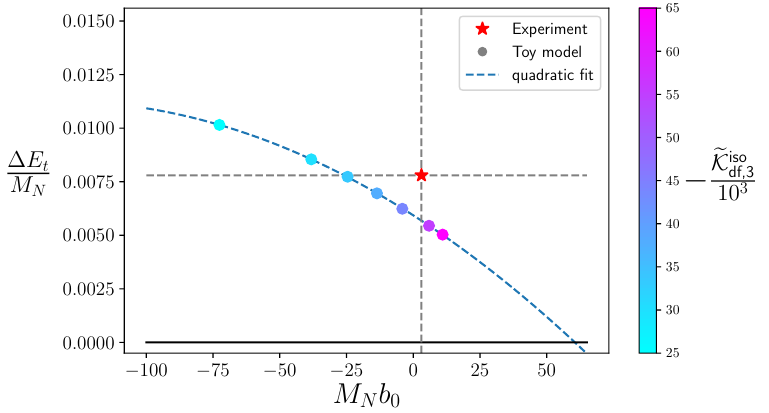
Figure 9 . Correlation between the triton (trimer) binding energy and the particle-dimer (nucleon- deuteron) scattering length. This is usually referred to as the Phillips line. The value of e K iso M 2 K iso used for each point can be determined from the color gradient at right. For further N df ; 3 discussion see the